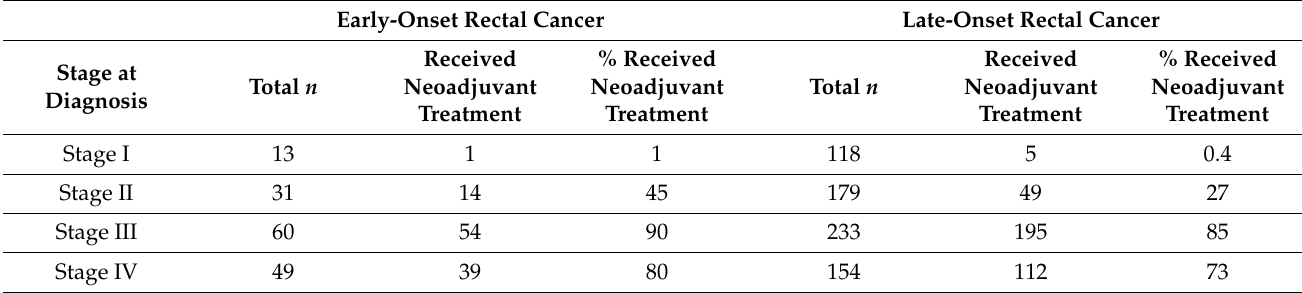
Table 3. Proportion of early- and late-onset colon cancer patients receiving adjuvant treatment by stage at diagnosis.